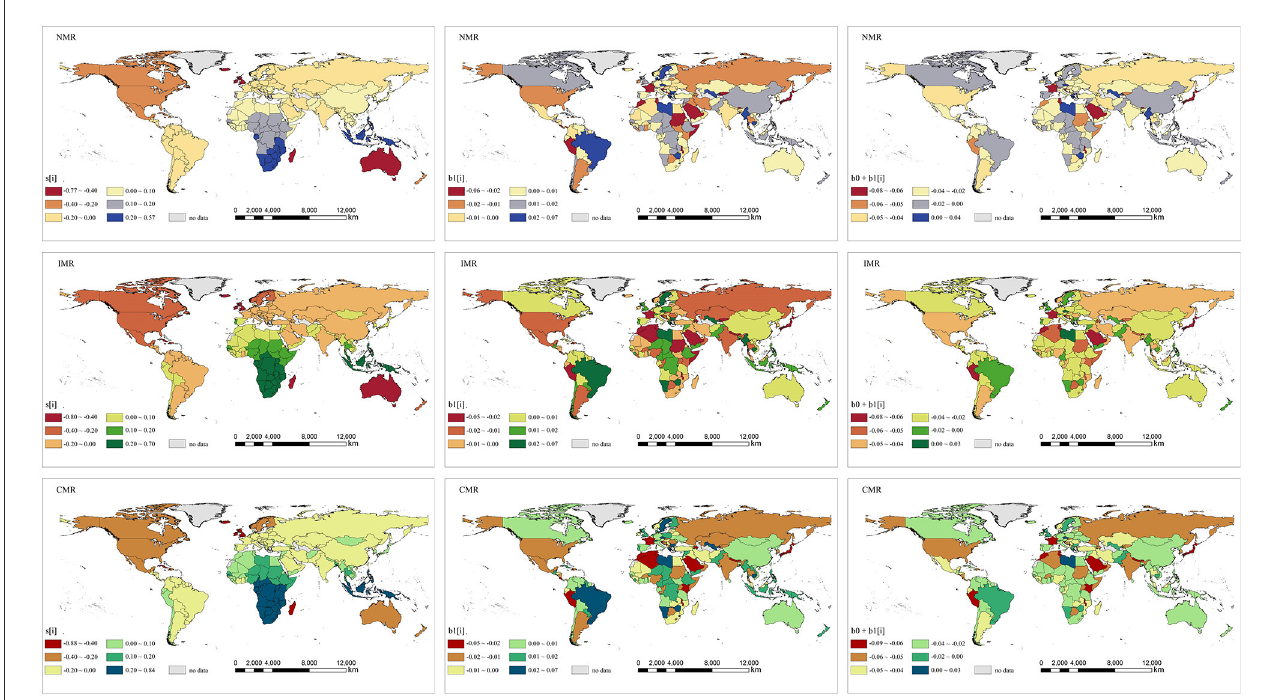
FIGURE7 Maps of the spatial relative departures, local temporal departures and local temporal trends of NMR, IMR, and CMR in 185 countries, 1990–2019. (Left column) The common spatial pattern (posterior medians of the spatial relative departures s i ), (Middle column) the local departures from the overall temporal trend (the posterior medians of local temporal departures b 1i ), (Right column) the country-specific temporal trends (the posterior medians of b 0 + b 1 i ).